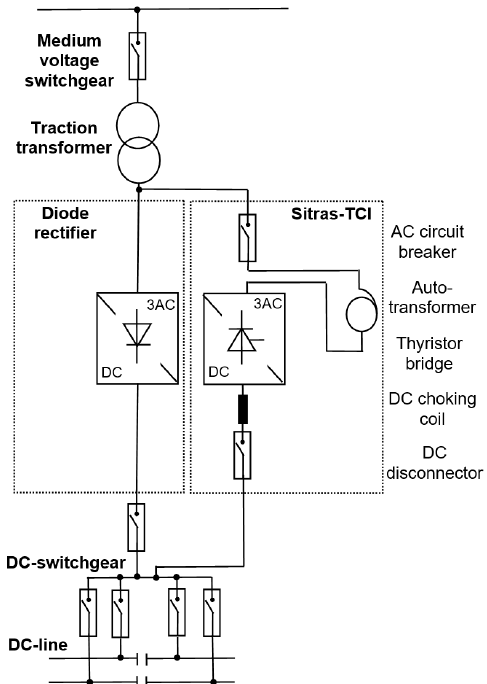
Figure 3. Schematic diagram of the Sitras TCI integrated into an existing DC-traction substation with uncontrolled rectifier [61,93].